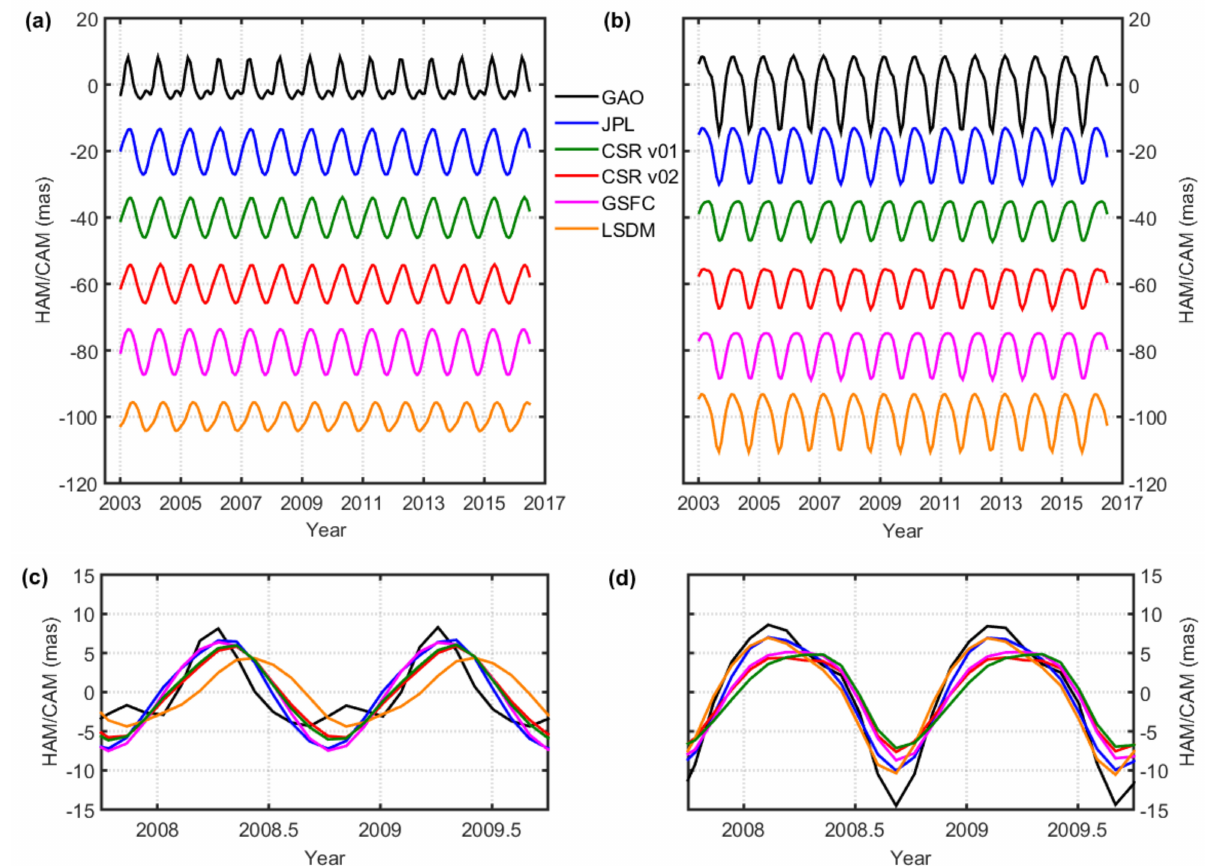
Figure 4. Comparison of seasonal time series of the ( a ) χ 1 and ( b ) χ 2 components of GAO, GRACE-based HAM/CAM, and LSDM-based HAM. Plots ( c , d ) present the same series as ( a , b ), but without adding a bias and with a changed scale on the x axis for better visibility of the seasonal cycle. The time period for ( c , d ) is between October 2007 and October